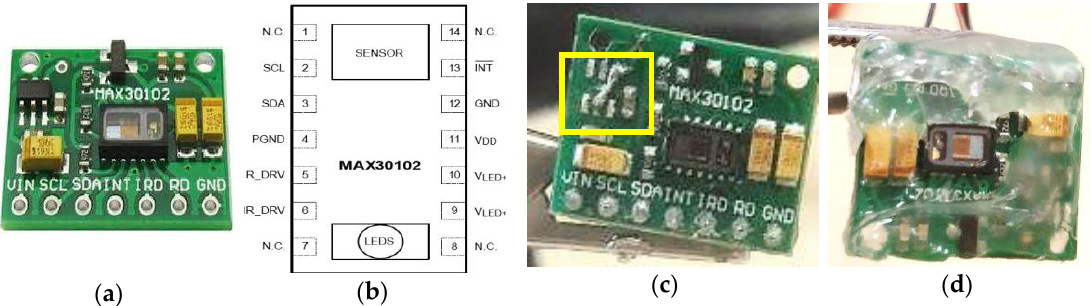
Figure 9. MAX30102 sensor board ( a ), its pinout ( b ); the sensor board after the modifications ( c ) coating with an insulating layer for the protection of pins from possible short-circuits ( d ).